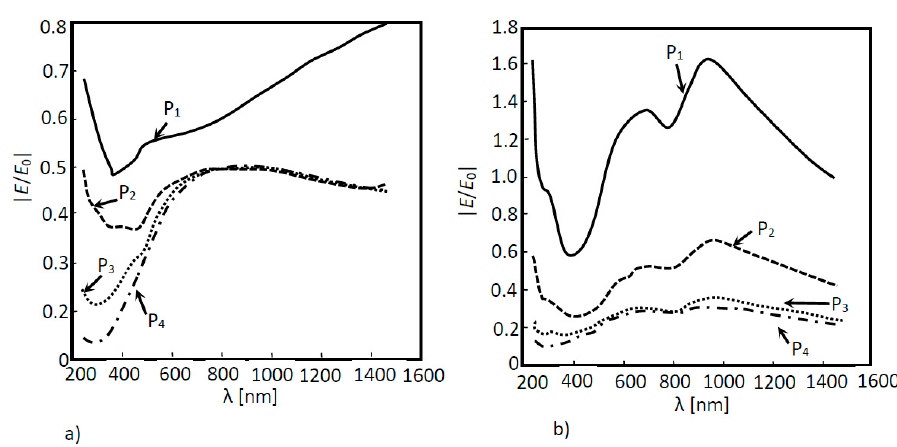
Figure 6. Normalized electric field as a function of the wavelength for a 3D a-Si solar cell structure. Measures were performed in four different positions: P 1 , P 2 , P 3 and P 4 for two different situations: ( a ) without a nanoantenna and ( b ) with a nanoantenna.